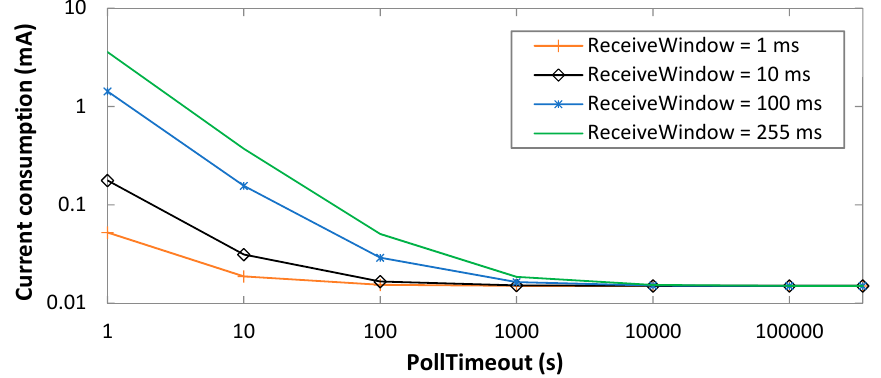
Figure 8. Average current consumption of the BM-LPN, as a function of PollTimeout, in absence of data message transmissions, and for various ReceiveWindow settings.